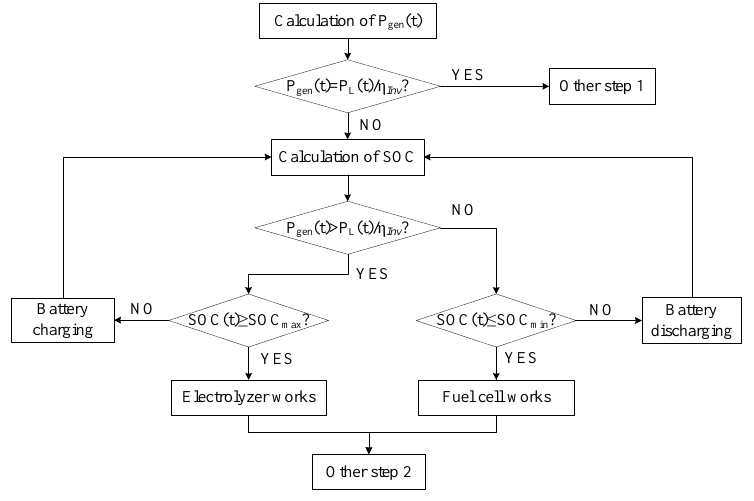
Figure 4. Operation strategy of the hybrid